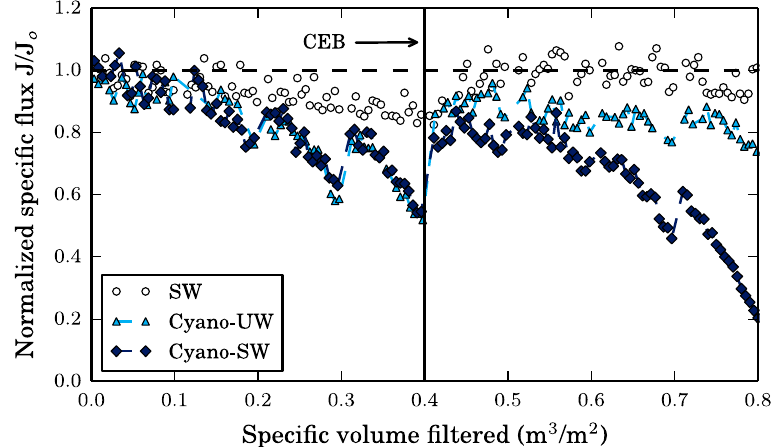
Figure 8. Decrease in the membrane’s specific flux during constant flux, dead-end filtration (200 LMH) of different feed solutions. The horizontal dashed line indicates the clean membrane flux. A 30-min ozone CEB was initiated after 2 h of filtration (600 LMH, 40 mg O 3 /L). Note that the Cyano-UW and the Cyano-SW are nearly aligned until the CEB.